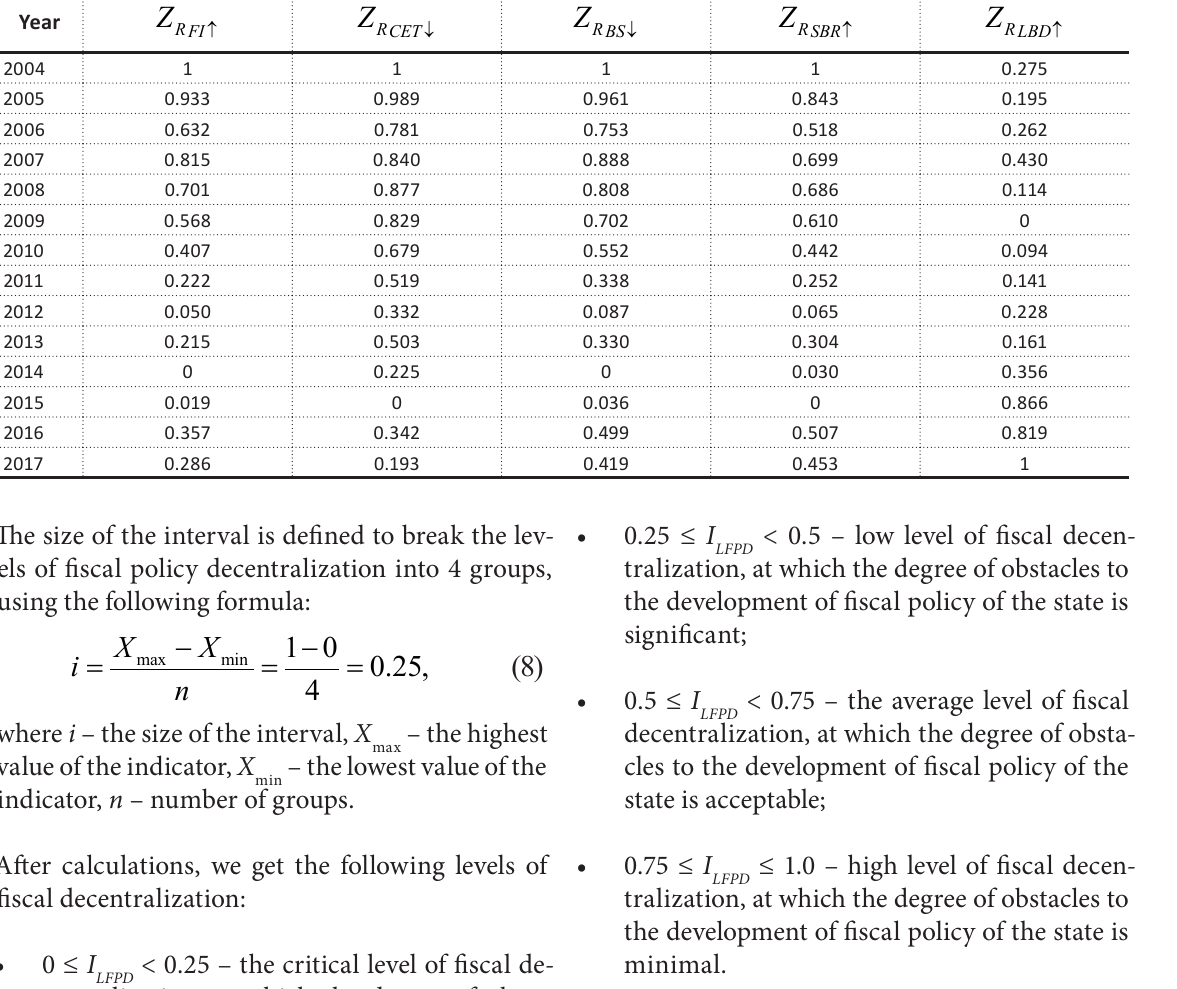
Table 13. Standardized single indicators of the component of the level of decentralization of intergovernmental relations in 2004–2017